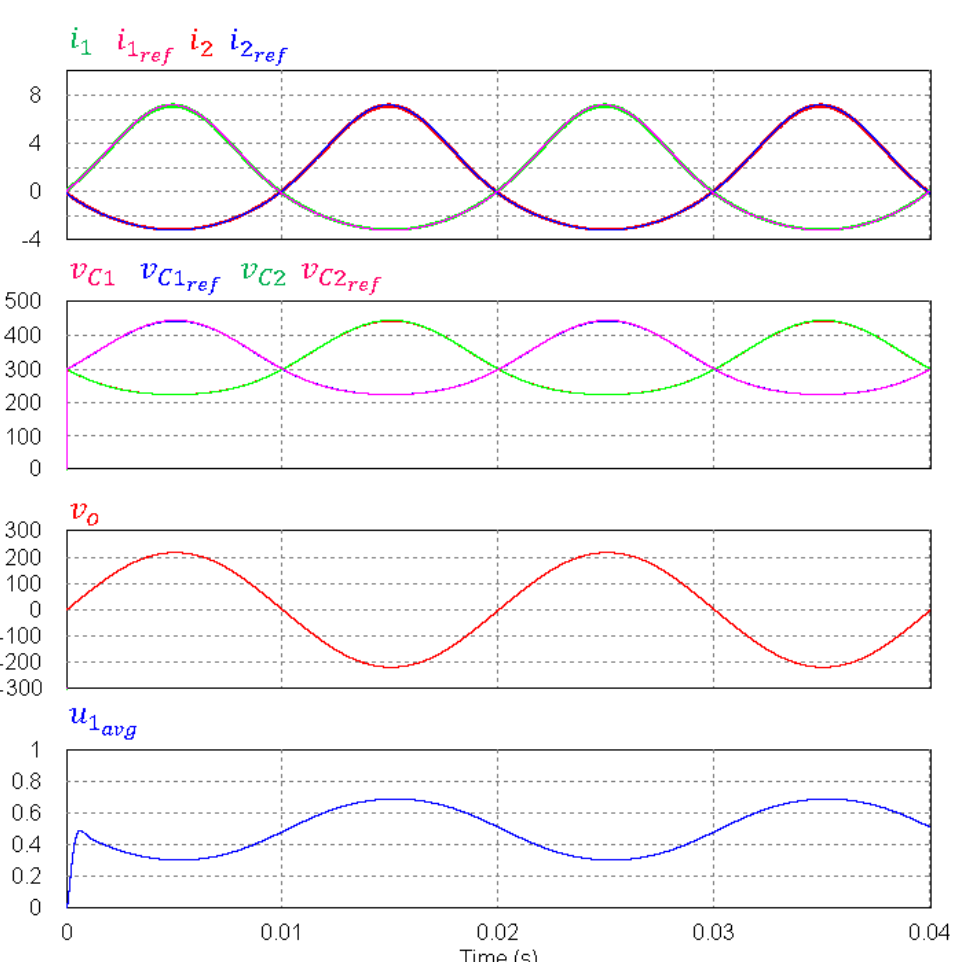
Figure 7. Simulated waveform of the boost inverter feeding a resistive load and using a single control